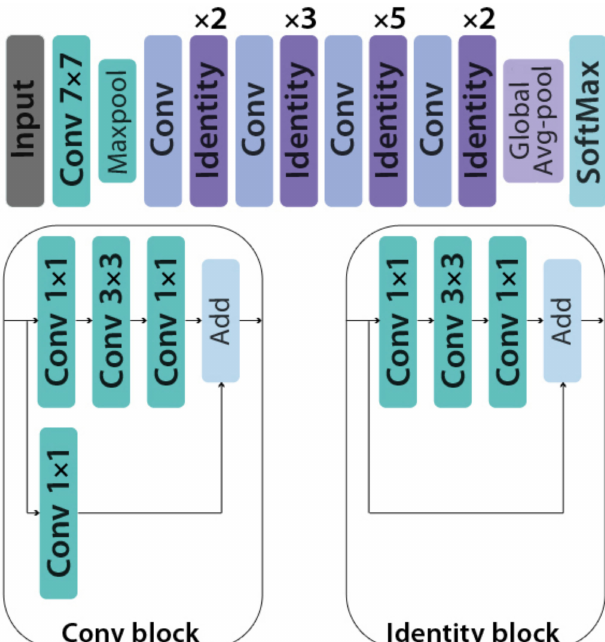
Figure 9. The structure of ResNet50 model.